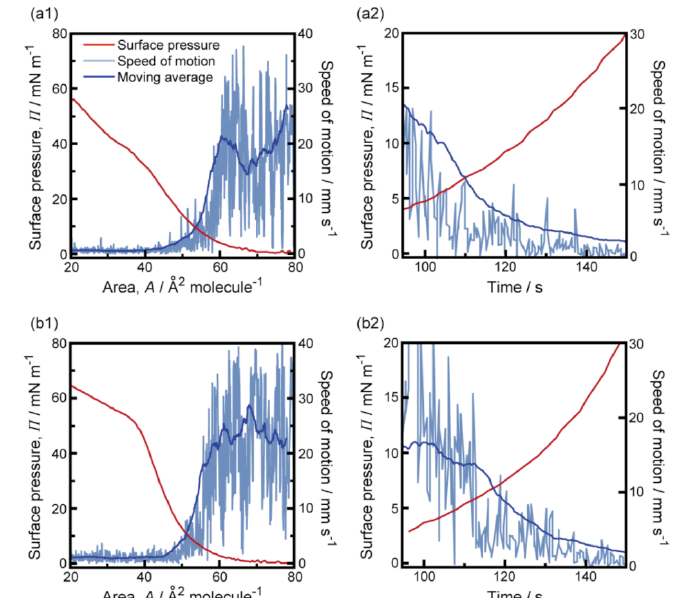
Figure 3. ( a1 , b1 ) Dependence of surface pressure (red lines) and moving average speed of the camphor disk (blue lines) on molecular area of MANA ( a1 ) and OPANA ( b1 ) at 293 K. Pale blue lines indicate actual speeds of the camphor disk; ( a2 , b2 ) time variations in surface pressure and speed of a camphor disk on the MANA and OPANA molecular layers at 293 K around the region β (4 ≤ Π ≤ 20 mN m − 1 ) were magnified in ( a2 ) and ( b2 ), respectively. The reproducibility of these experiments was certified by a minimum of three